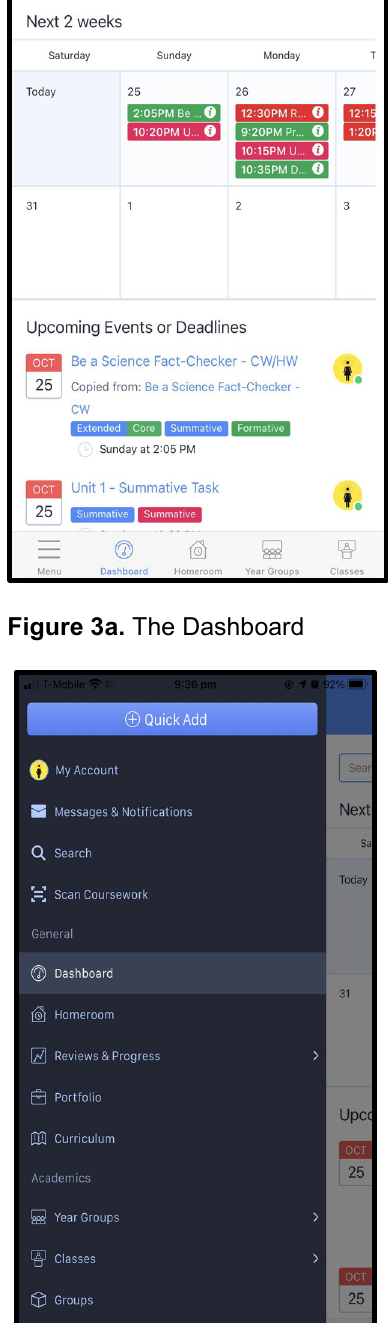
Figure 3d. Individual class